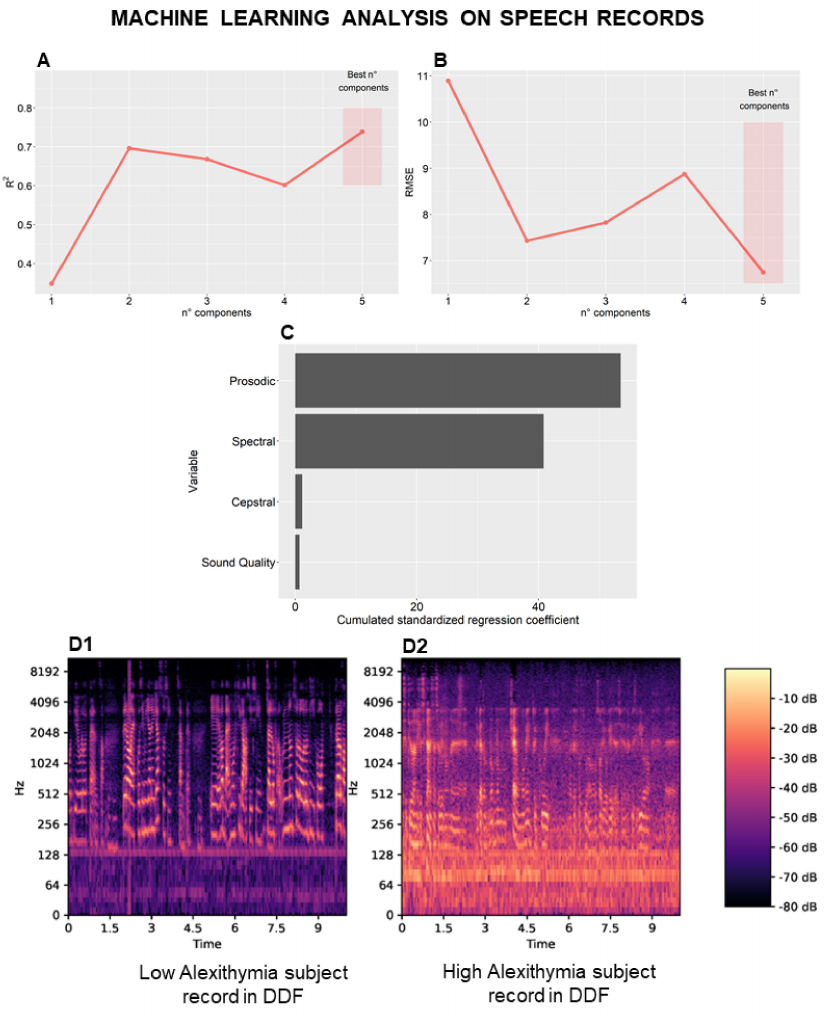
Figure 3. Machine Learning Analysis on Speech Records. Univariate correlation filtering was applied to select 212 candidate acoustic features belonging to the ComParE feature set and Principal Compo- nents Regression (PCR) model with 5 components was selected as the best fitting based on R 2 and Root Mean Square Error (RMSE) metrics in Leave-One-Out Cross-Validation (LOOCV) (R 2 = 0.74; RMSE = 6.74) ( A , B ). Relative variable importance was computed over the domains of ComParE low- level descriptors, namely sound quality, spectral, cepstral, and prosodic ( C ). Representative differences in audio tracks (recorded in responding to an item of Difficulty in Describing Feelings—DDF) from High Alexithymia subjects and Low Alexithymia subjects can be observed in spectrograms ( D1 , D2